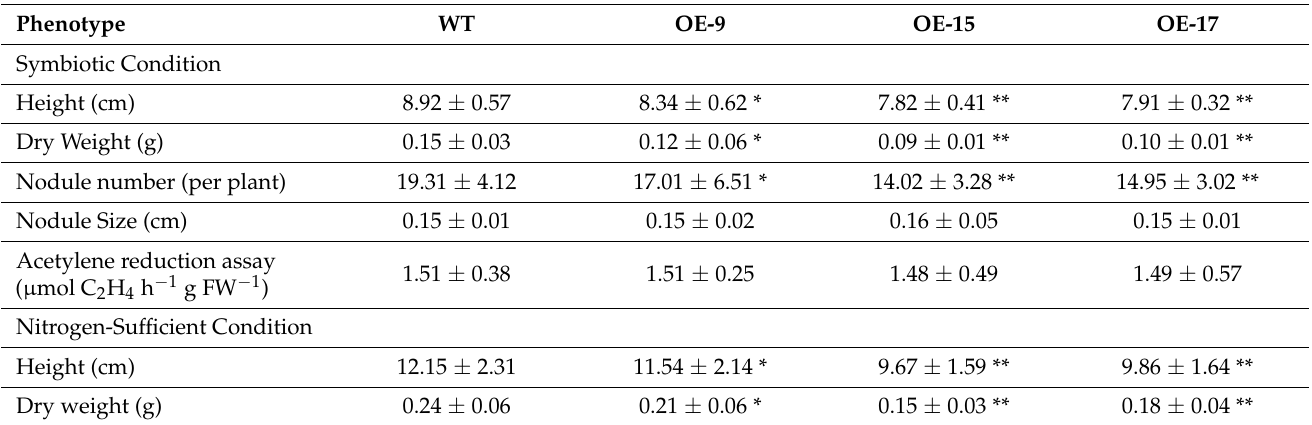
Table 1. Phenotypic characteristics of OEPLT3